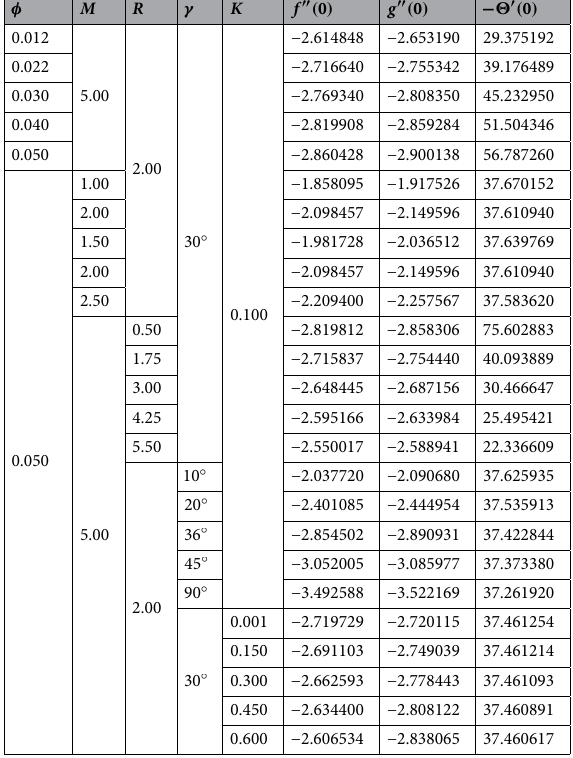
Table 2. Skin frictions and local Nusselt number for various values of φ , M , R , γ , K while Pr = 6.2 .